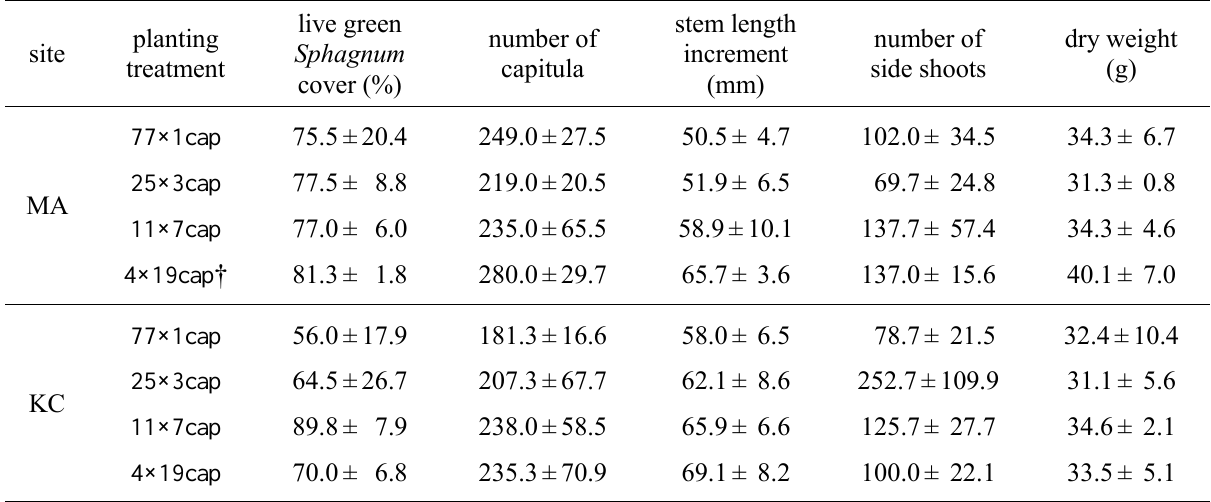
Figure 6. Monthly progress of live green Sphagnum cover (%, mean value for three replicas) for the four planting treatments ‘77×1cap’(a), ‘25×3cap’(b), ‘11×7cap’ (c) and ‘4×19cap’ (d) at the MA (Mount Aso, solid line) and KC (Kumamoto City, dotted line) experimental sites during the 7-month growing season of 2008. The data for months (September to November) marked with daggers (†) at MA do not include the cover values for one replica because the colonies suffered animal damage. * denotes a significant difference (one-way ANOVA test) at p < 0.05. Table 3. Measurements of Sphagnum colony attributes (mean ± SD for three replicas) at the end of the first growing season (seven months, April to November 2008) for the Mount Aso (MA) and Kumamoto City (KC) experimental sites. Only two replicas of the planting treatment marked with a dagger (†) were included in the analysis because the third one suffered animal